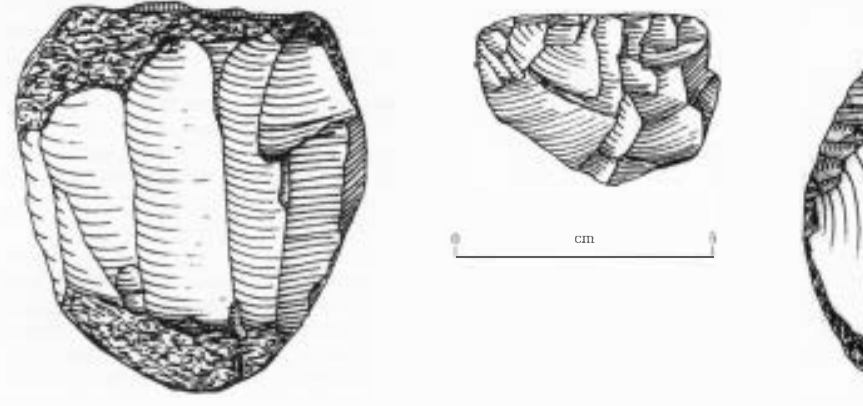
Figure 3 Different LBK core-types in Klein Auheim (drawn by Ulrike Sommer and Birgit